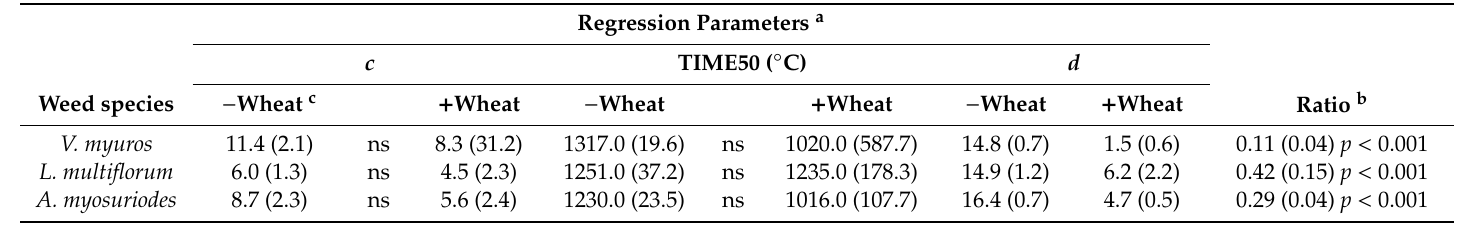
Table 2. Regression parameter estimates from weibull function Equation (2) fitted to per plant biomass accumulation of grass weeds in the absence and presence of winter wheat in 2017 / 18. Regression estimates were compared within grasses grown in the absence and presence of winter wheat at the 5% level of significance. Standard errors are given in parentheses.